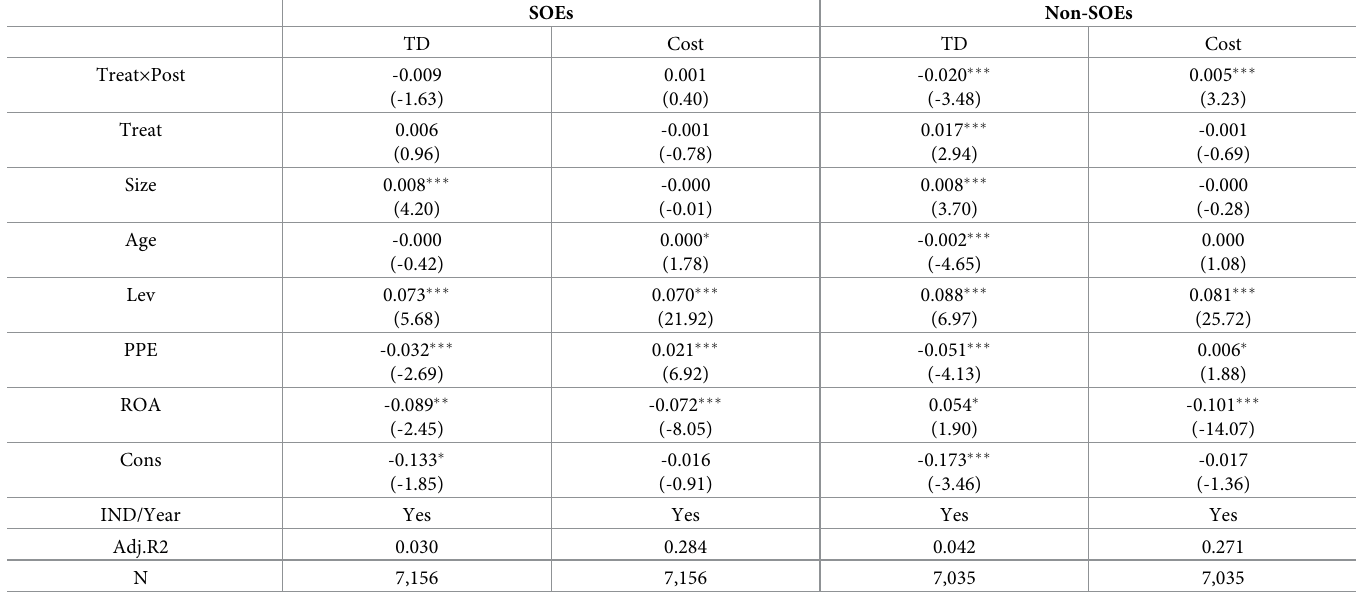
Table 9. Impacts of ownership